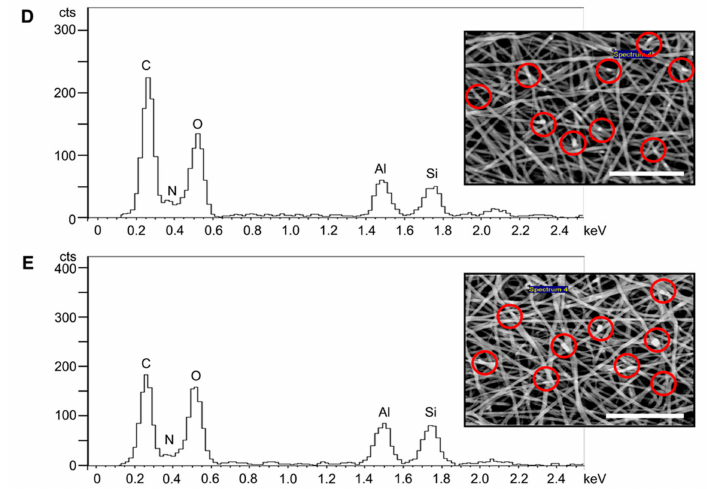
Figure 2. Identification of HNTs within the scaffolds. EDS spectra of SF/HNT composite scaffolds ( A ) SF, ( B ) SF/HNT 1 wt%, ( C ) SF/HNT 3 wt%, ( D ) SF/HNT 5 wt%, and ( E ) SF/HNT 7 wt%. Inserts: Scanning electron micrographs of the samples analysed. Red circles: HNTs incorporated into the SF fibres; scale bar: 10 µ m.